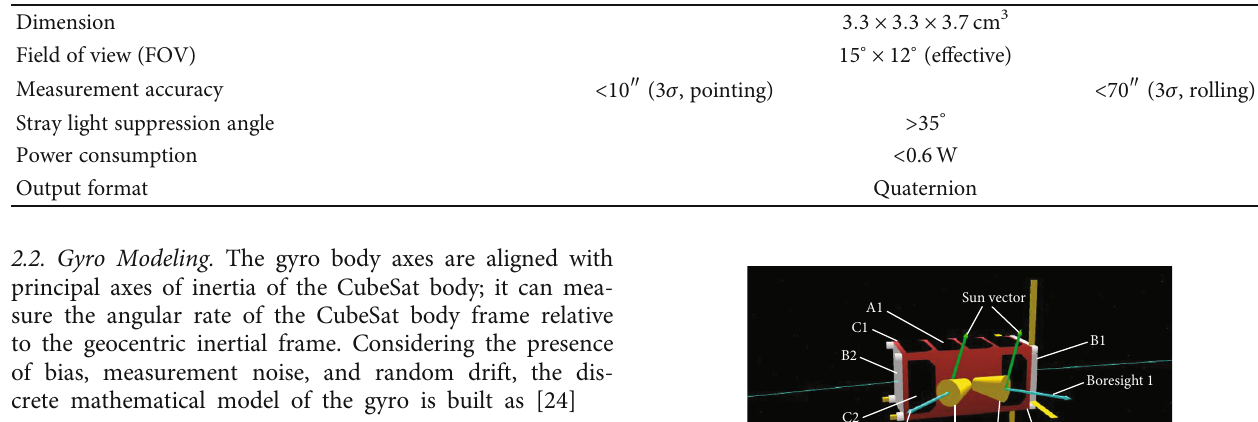
Table 1: PST3 pico STR performance.